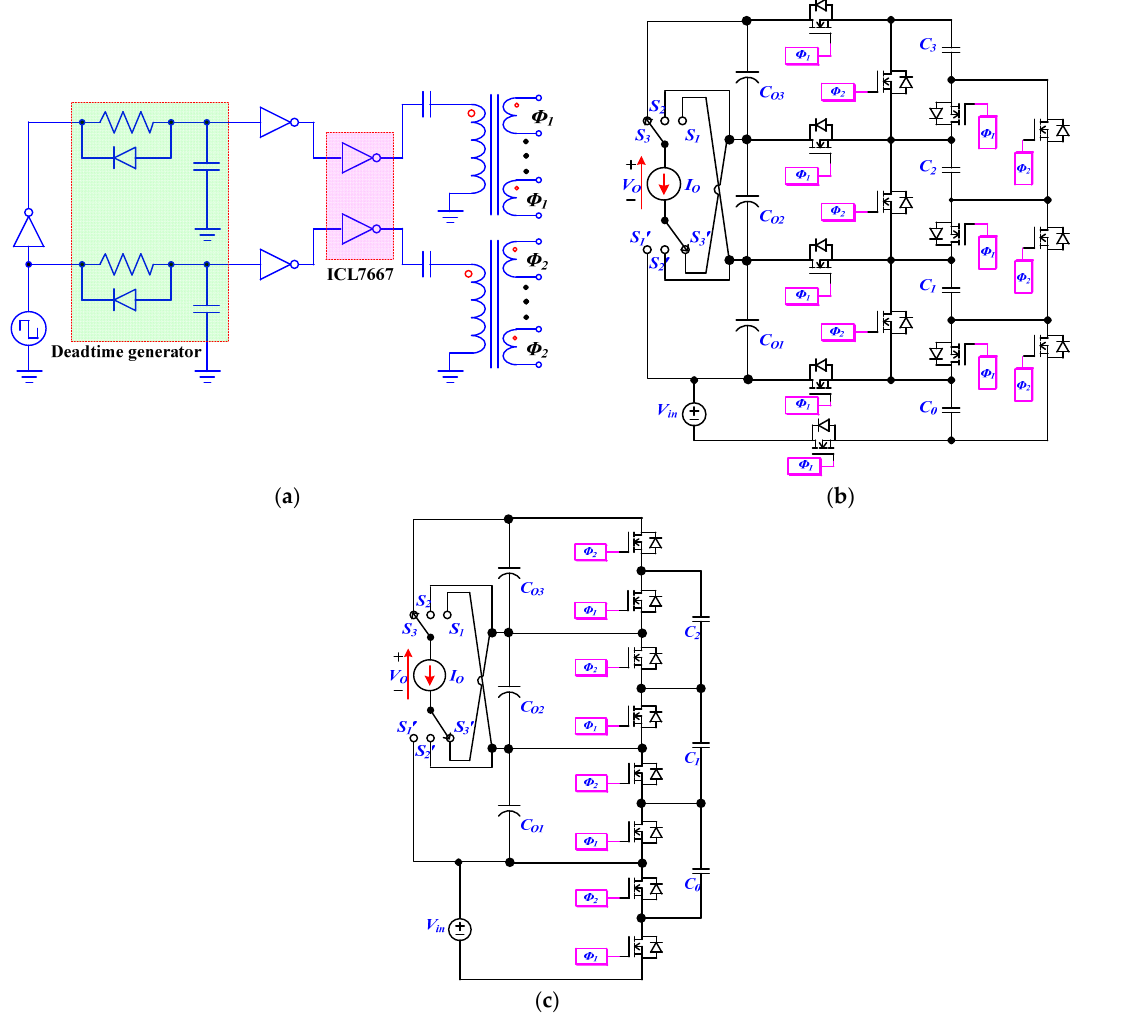
Figure 11. Gate driver circuit and test systems of both the conventional and proposed SC equalizers: ( a ) gate driver circuit of switches; ( b ) test system of the proposed equalizer; and ( c ) test system of the conventional SC equalizer.